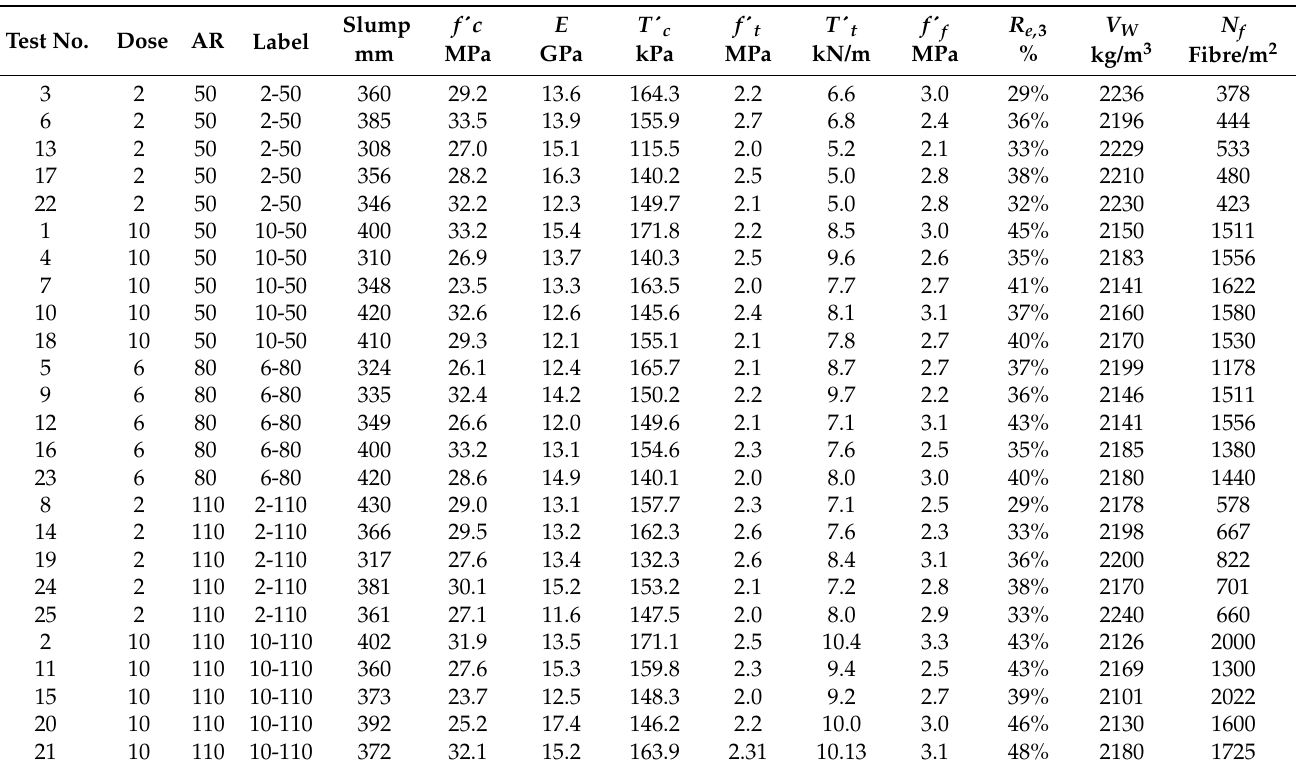
Table 2. Results of concrete with recycled PET fibres in different doses and aspect ratios. Test